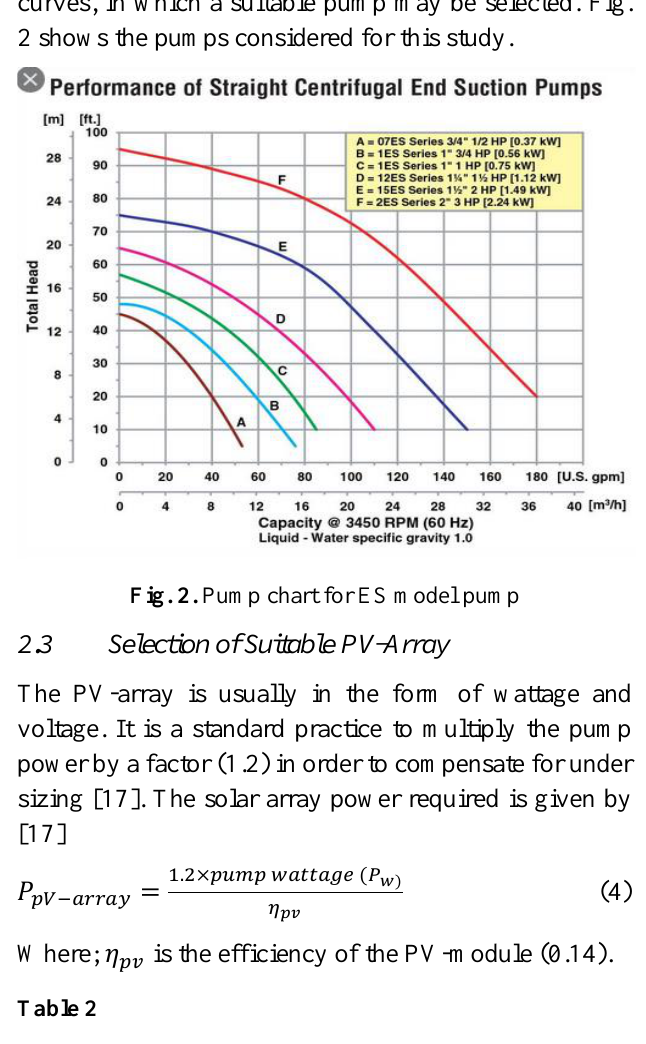
Characteristics of the selected PV-module [22] Parameters